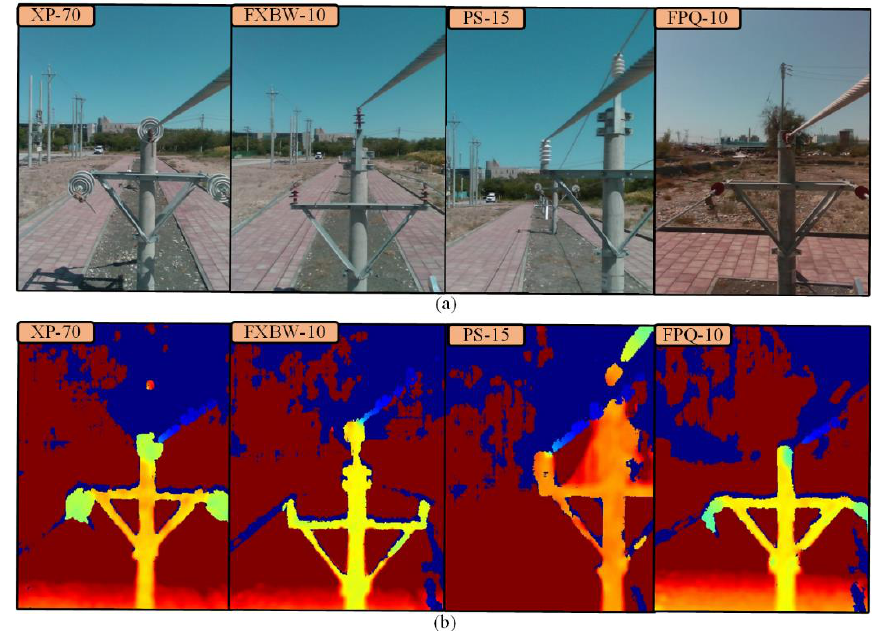
Figure 20. Illustration of the test dataset. ( a ) RGB images; ( b ) depth maps. The test dataset is annotated using labelImg software, saving as YOLO format. The names of RGB images, annotation files, and depth maps are strictly